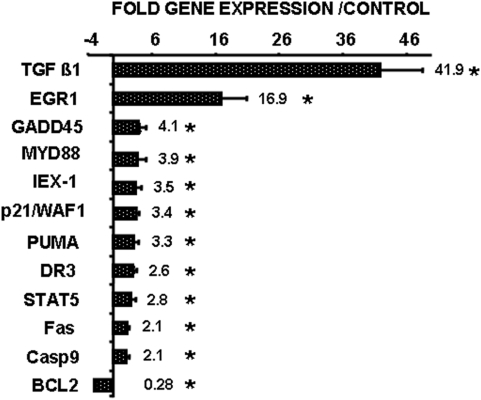
Gene expression profile in cells with conditional Sp3 expression.Expression of 88 pro- and anti-apoptotic genes was tested in LS174 cells conditionally expressing Sp3 (S27) by real time PCR. The variations of the significantly modified genes (* p<0.05) are represented. The mean fold increase±SD of three independent experiments performed in triplicate, is plotted.